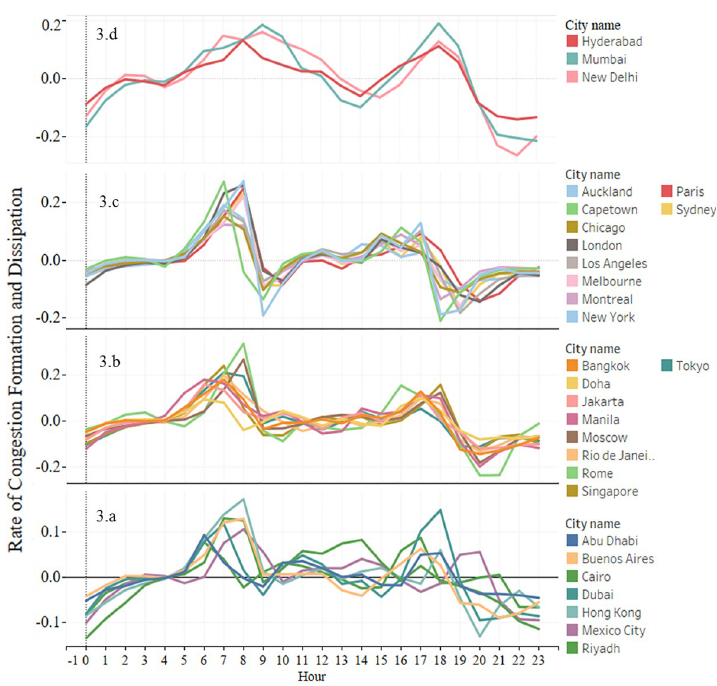
Fig 4. Formation and dissipation of congestion in different cities. a. cities with a low congestion index, b. and c. cities with moderate to high congestion index, d. an exception where the rate of dissipation is found to increase as the congestion